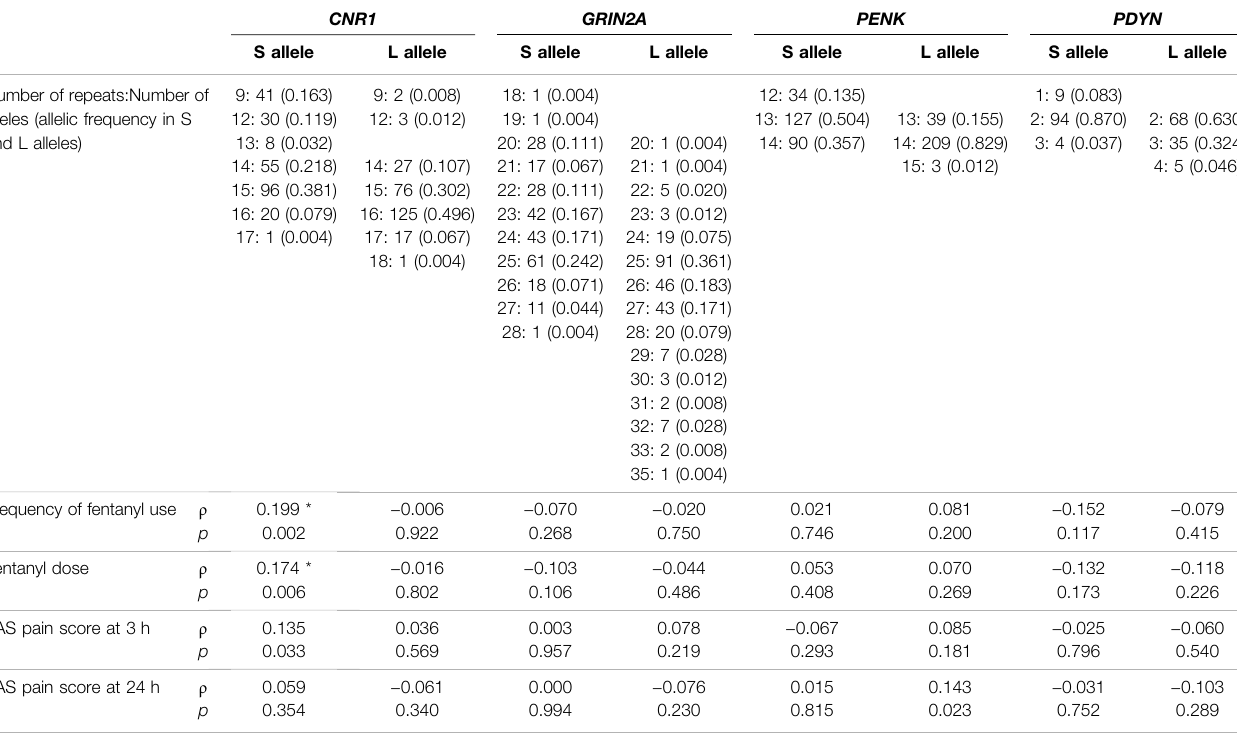
TABLE 5 | Associations between S and L alleles of STRs and postoperative analgesia in patients who underwent orthognathic cosmetic surgery. CNR1 GRIN2A PENK PDYN S allele L allele S allele L allele S allele L allele S allele L allele Number of repeats:Number of alleles (allelic frequency in S and L